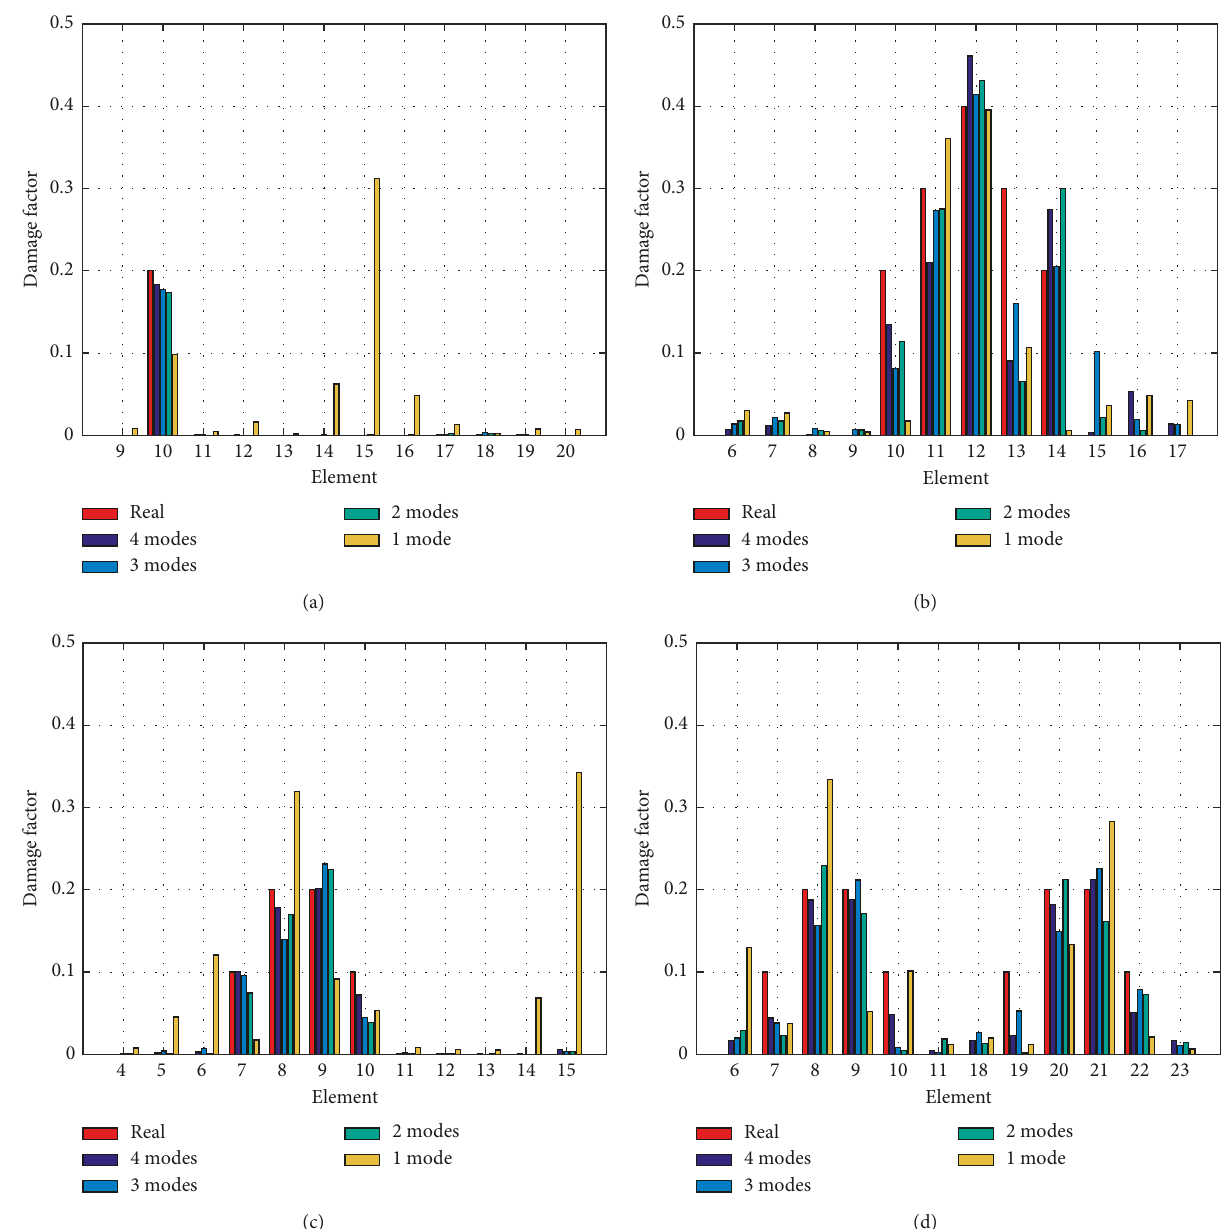
Figure 17: Frame example: performance of the combined criterion for different damage scenarios (noise 5%). (a) Scenario 1, (b) scenario 2, (c) scenario 3, and (d) scenario